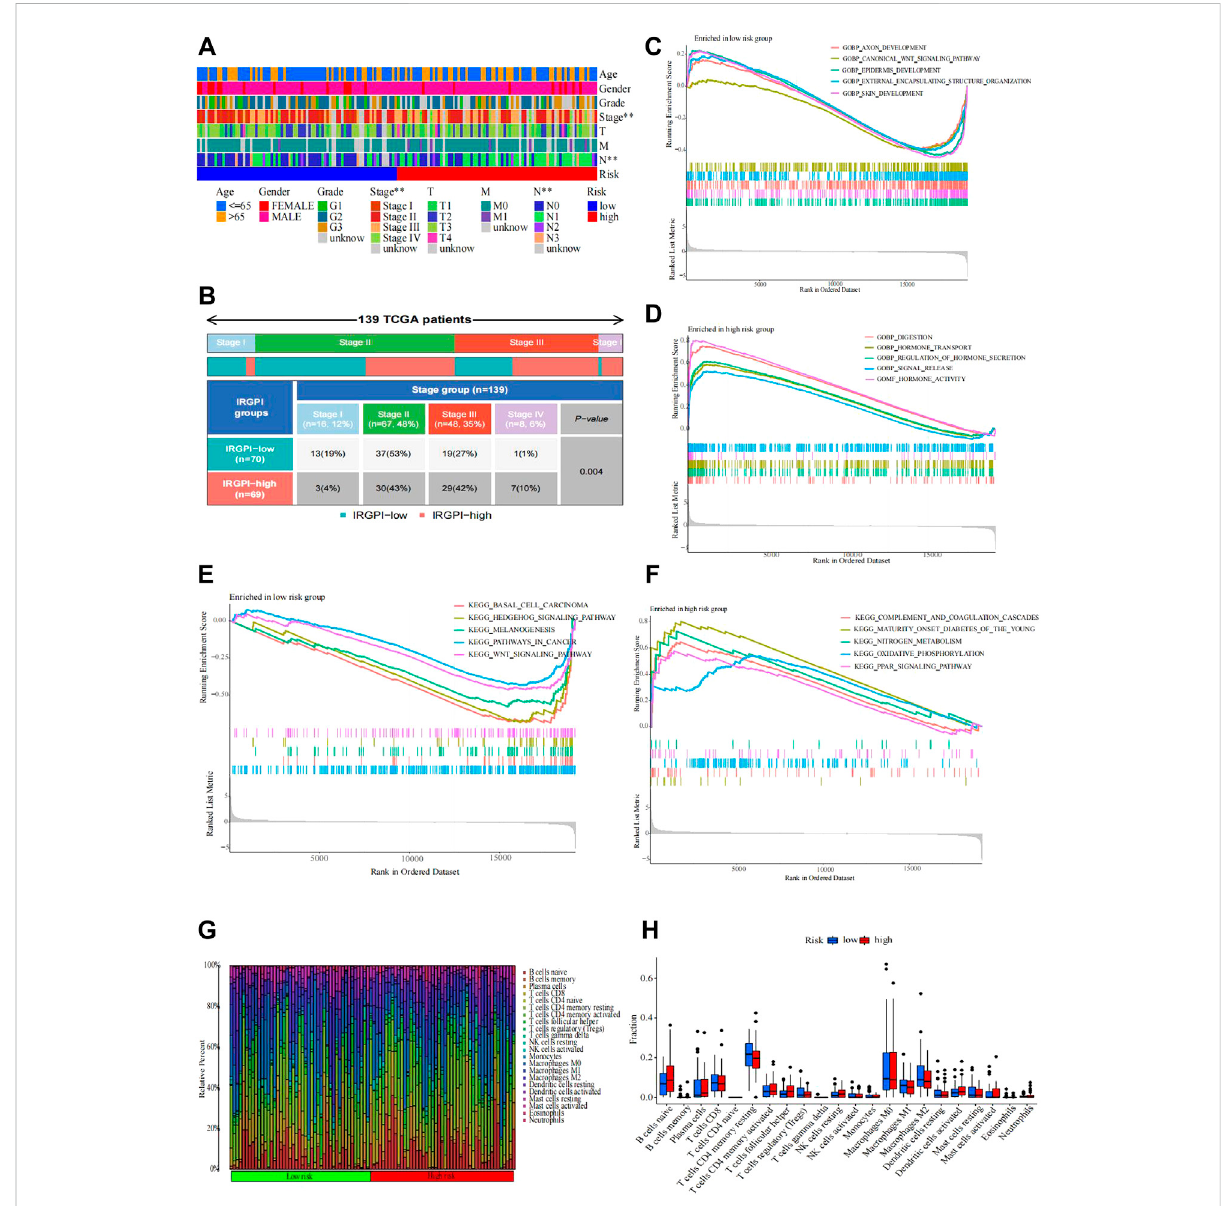
FIGURE 4 Distribution causes that affect patient prognosis. (A,B) Heatmap and table of the EC OS prognostic (age, sex, grade, stage, T, M, and N) between the IRGPI subgroups. (B) Heatmap and table of the stage between the IRGPI subgroups, and the distribution was compared through the χ 2 test ( n = 139, p = 0.004 < 0.05). Molecular characteristics of different IRGPI subgroups in GO and KEGG enrichment analyses. (C – F) GO enrichment analysis of gene sets enrichedintheIRGPI-lowandIRGPI-highsubgroups( p < 0.05,FDR < 0.25). (F) KEGGenrichmentanalysisofgenesetsenrichedinIRGPI-lowandIRGPI- high subgroups ( p < 0.05, FDR < 0.25). Pattern of the TME and characteristics of different IRGPI subgroups in esophageal cancer. (G – H) Proportion of TME cellsindifferentIRGPIsubgroups. (H) ImmunecellIRGPIsubgroups.Scatterpointsrepresenttheimmunescoresofthetwosubgroups.Thicklinesrepresent the median. The bottom and top of the box are the 25th and 75th percentiles (interquartile range), respectively. Signi fi cant differences between the two subgroups were assessed using the Wilcoxon test (ns, not signi fi cant; *, p < 0.05; **, p < 0.01; ***, p < 0.001; ****, p <